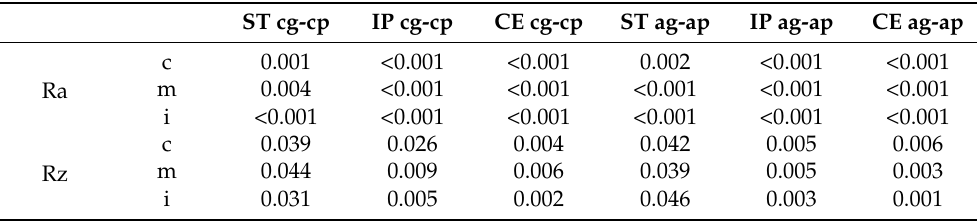
Table 4. The unpaired t -Test test ( α = 0.05)- p values regarding Ra, Rz for control, glazed-control polished, respectively aged glazed-aged polished groups in each area. ST